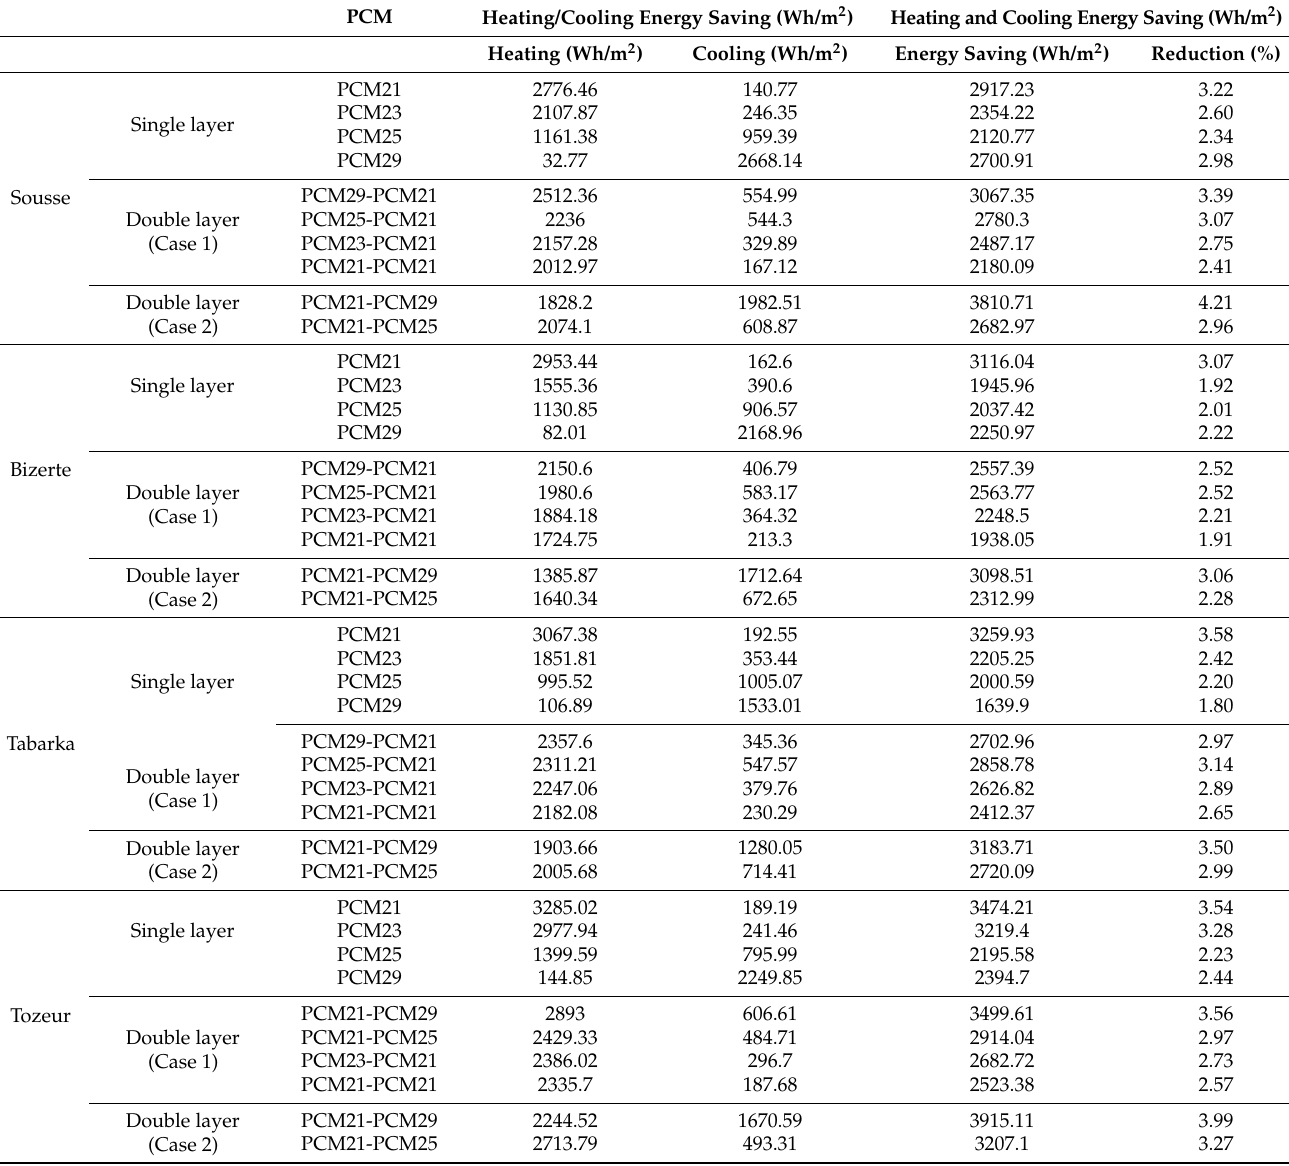
Figure 8. Schematic representation of double layer of PCM location in wall ( a ) Case 1 and ( b ) Case 2. Table 5. Effect of PCM double layers (10 mm) on energy saving for four regions.